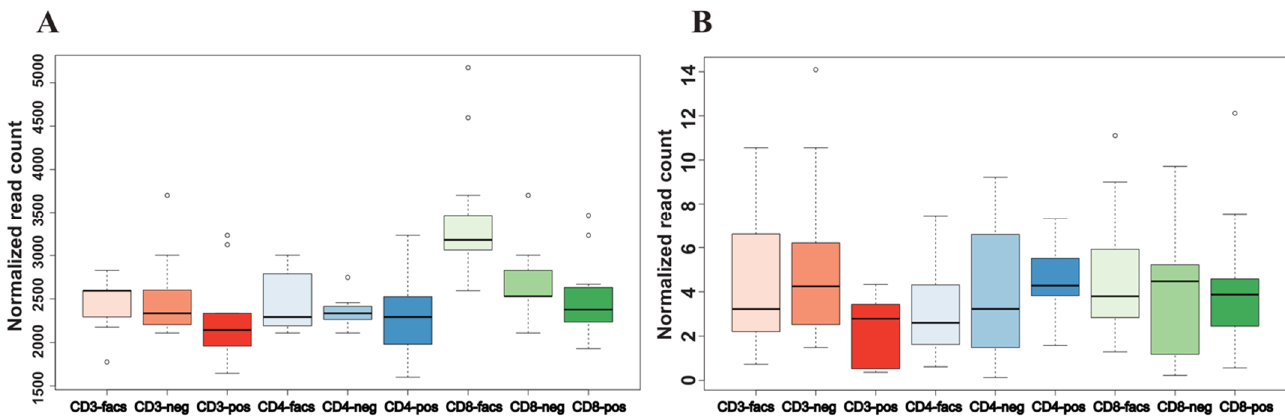
Figure 5. The normalized expression levels for two high-confidence miRNAs across different extraction techniques by PBMCs. ( A ) Hsa-miR-30a-3p. ( B ) Hsa-miR-139-5p. FACS: fluorescent activated cell sorting, neg: negative immunomagnetic selection, pos: positive immunomagnetic selection.